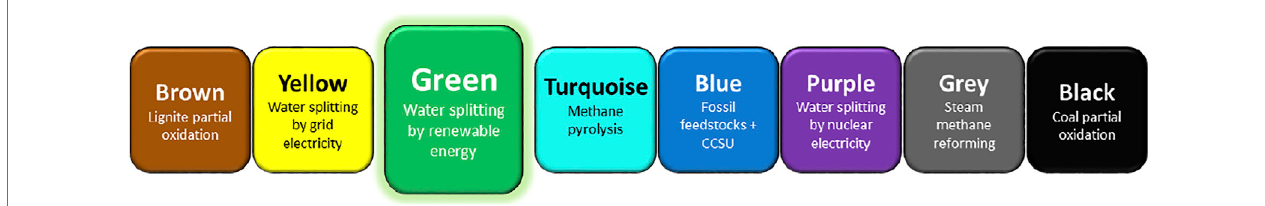
FIGURE 1 | The colors of hydrogen production